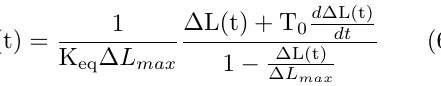
Figure 3. For experiment 1 and 3 the sensor